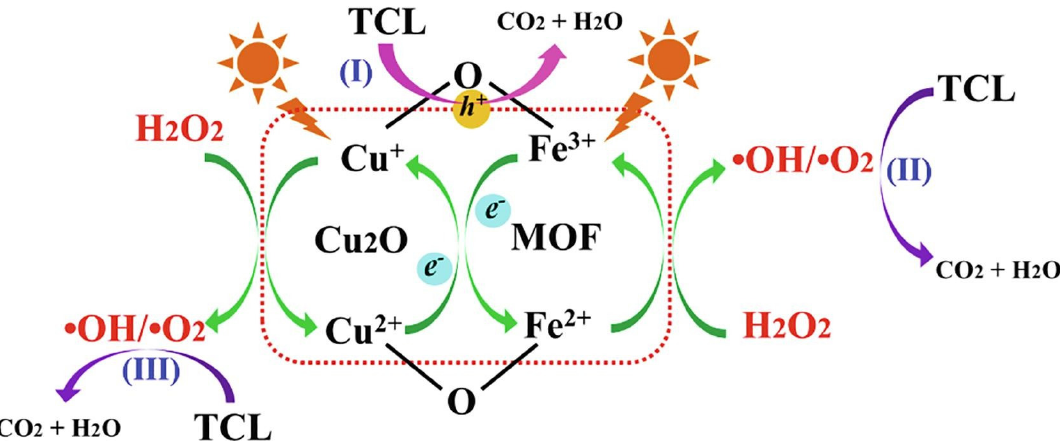
Figure 10. Proposed reaction mechanism for the photo–Fenton degradation of TCL over Cu 2 O / MIL ( Fe / Cu ). Reprinted with permission from Ref. [112]. Copyright 2020,